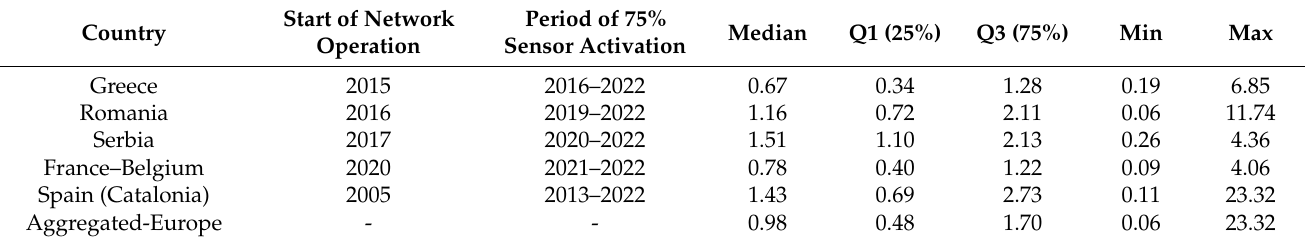
Table 1. Descriptive statistics parameters (start of operation, 75% sensor activation period, median, 25th and 75th percentiles, minimum and maximum) for the E rms (V/m) values of monitoring sensors grouped by country.